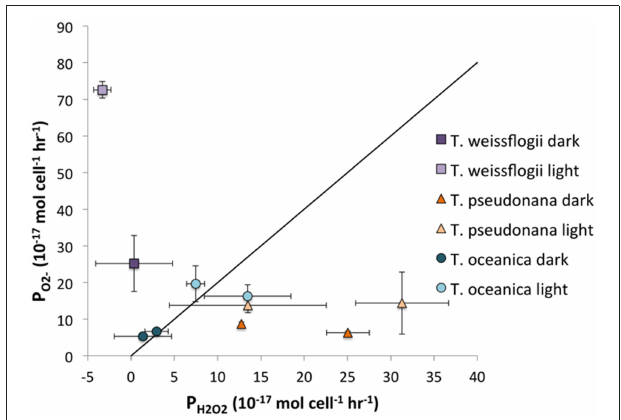
FIGURE 8 | Representation of the P O2 − :P H2O2 ratio. The diagonal line indicates the 2:1 ratio that would be obtained if all H 2 O 2 was produced through dismutation of O − 2